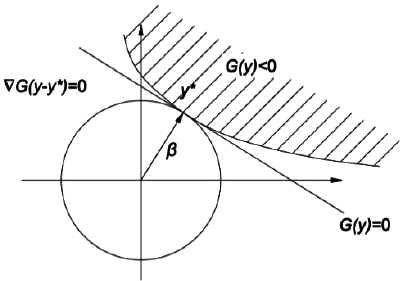
Fig. 2. Graphical presentation of limit state surface approximation according to the first-order reliability